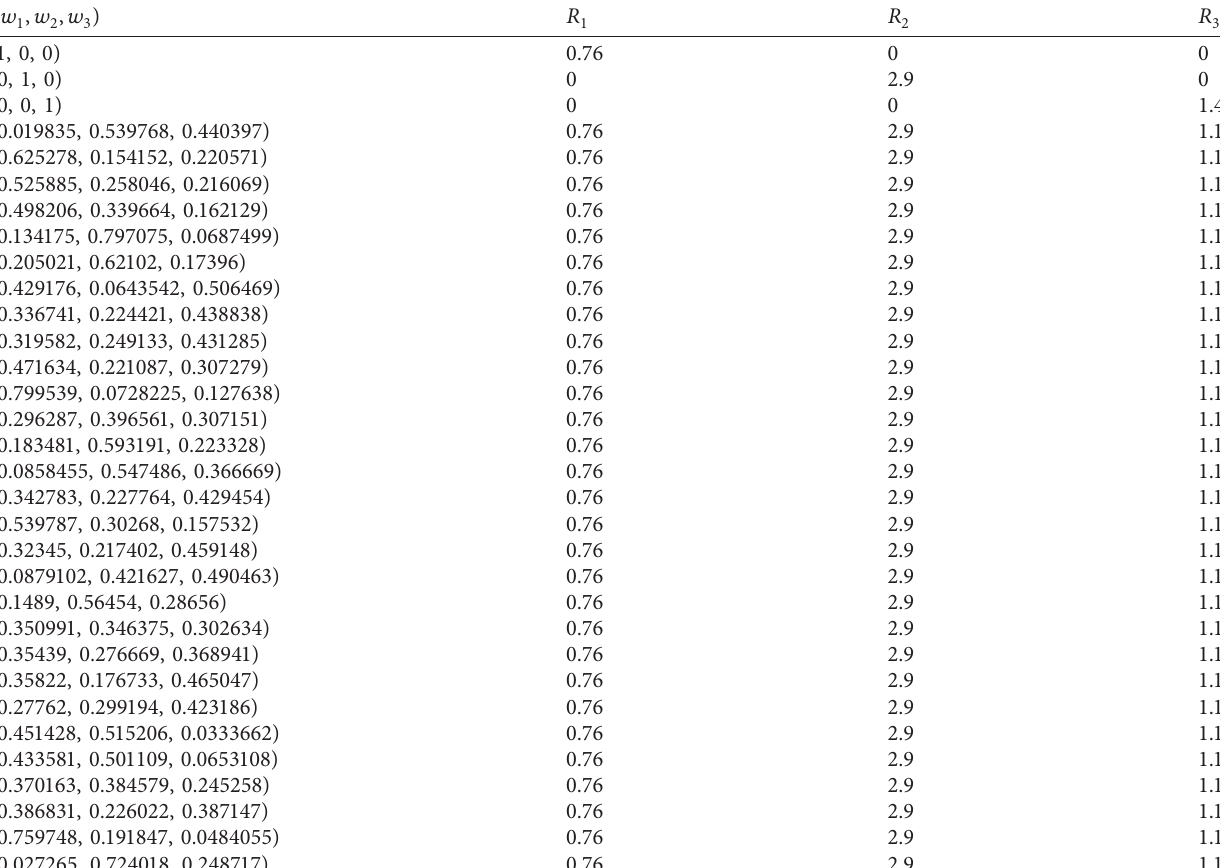
Table 8: Numerical result of the proposed